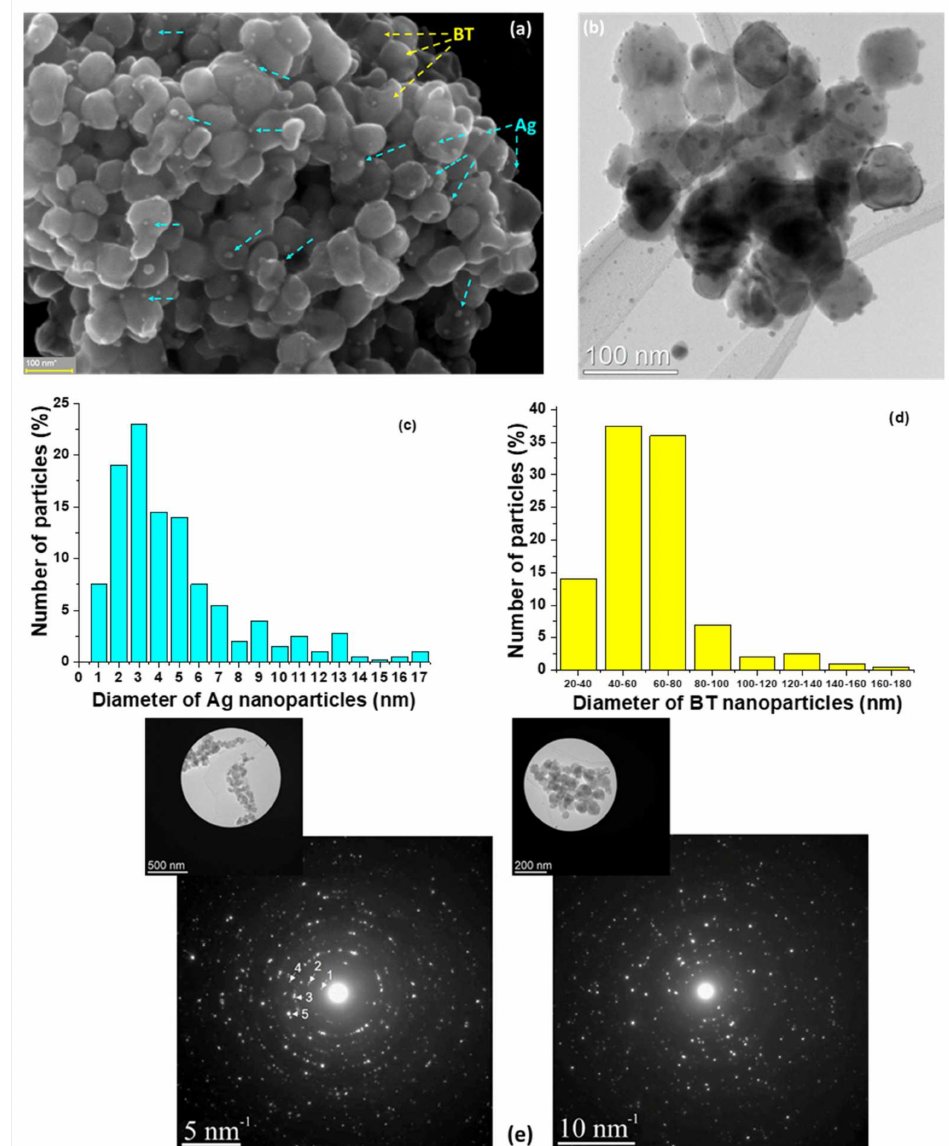
Figure 2. Microstructural characterization of 2%Ag-98%BT hybrid powders: ( a ) SEM micrograph for aggregated hybrid nanoparticles, ( b ) TEM image of the dispersed nanoparticles, ( c ) Particle size distribution for Ag ( c ) and BaTiO 3 components ( d ) of the hybrid Ag-BT mixtures, and ( e ) diffraction diagrams realized on Ag-BT aggregated nanoparticles and their corresponding SAED